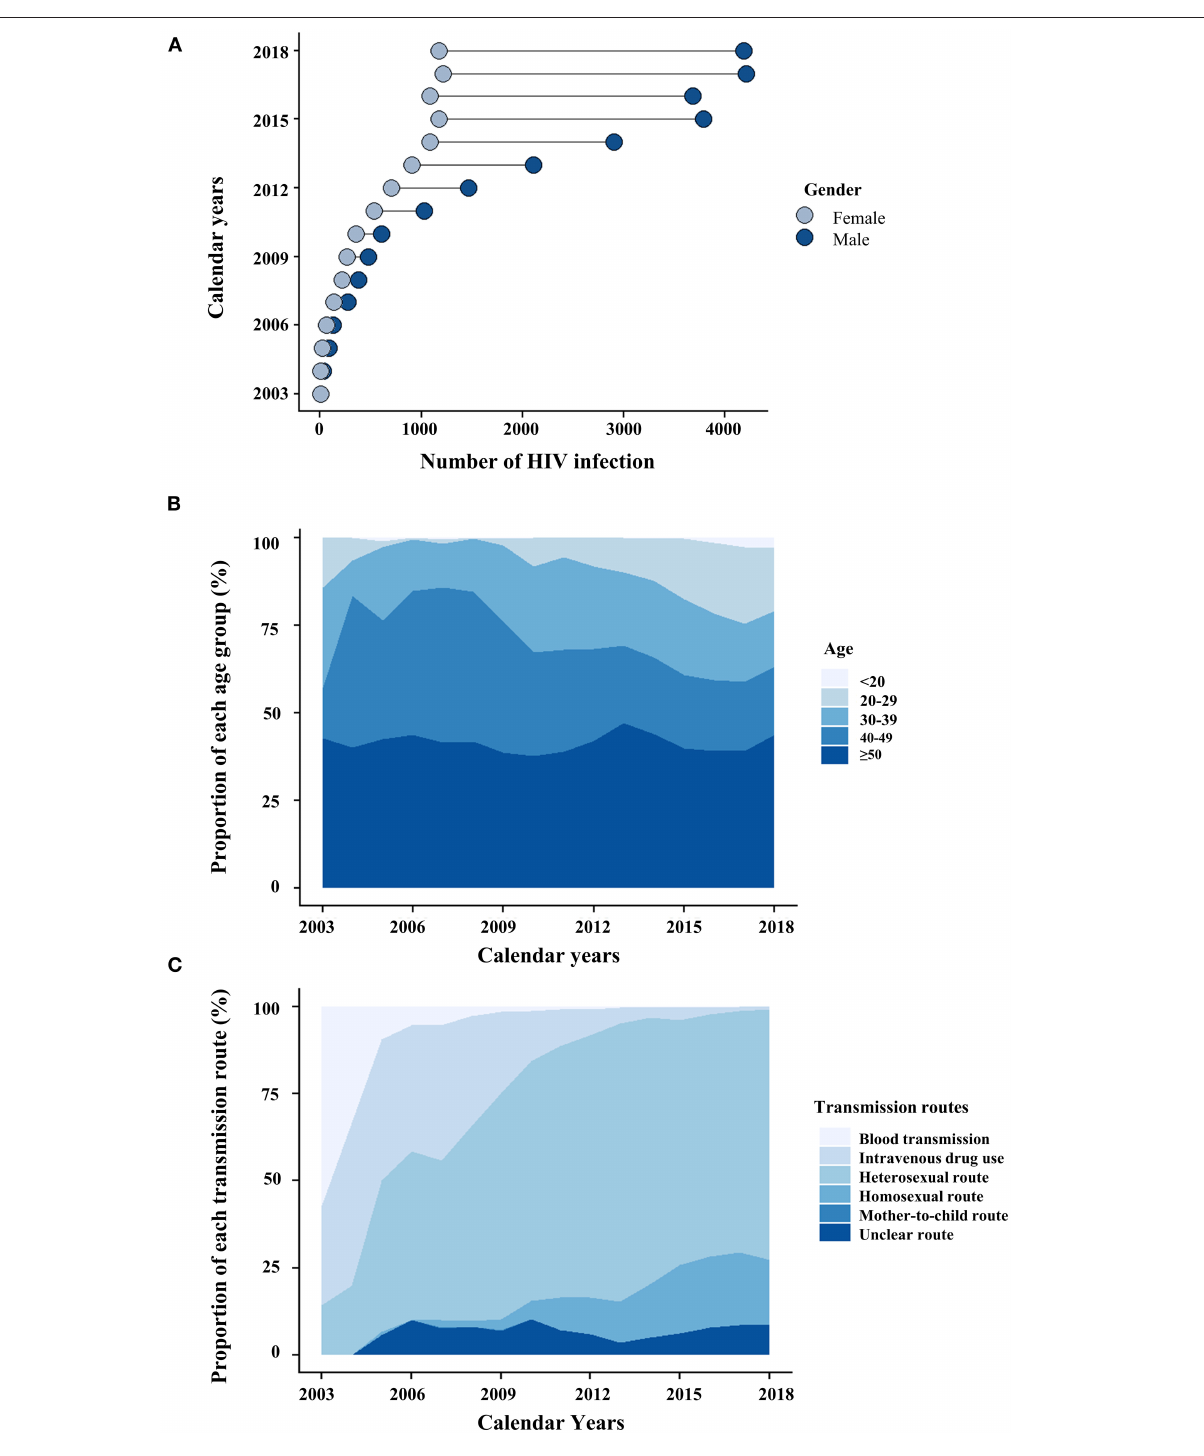
transmission are growing in recent years (23–25). Furthermore, the geographical distribution of HIV infections varies in different provinces and regions in China (14). For instance,